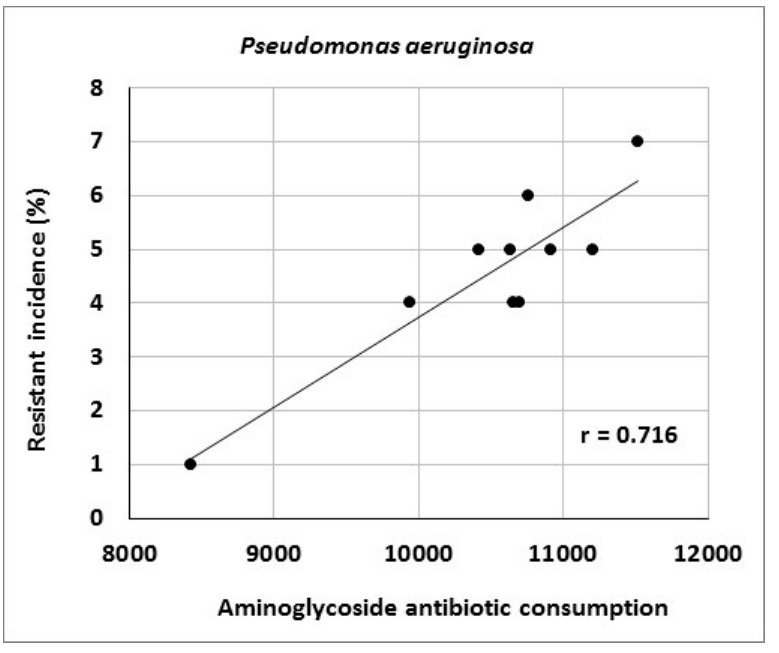
Figure 3. Correlation between aminoglycoside consumption (in numbers of defined daily doses) and resistance of Pseudomonas aeruginosa to amikacin. Table 7. Antibiotic consumption in defined daily doses (DDDs) at the University Hospital Olomouc . Tables 8–11 document resistance of particular bacterial species at the Department of Anesthesiology and Intensive Care Medicine over the study period. The results show Antibiotic Class/Antibi- increasing resistance of Escherichia coli to piperacillin/tazobactam (r = 0.845) and cefotaxime otic